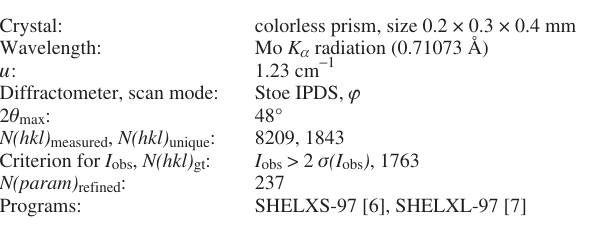
Table 1. Data collection and handling.